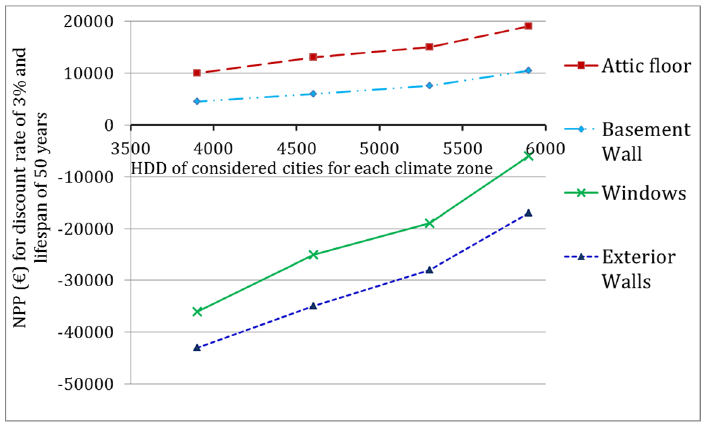
Figure 20. The trend of changes in the cost ‐ effectiveness due to HDD variation.